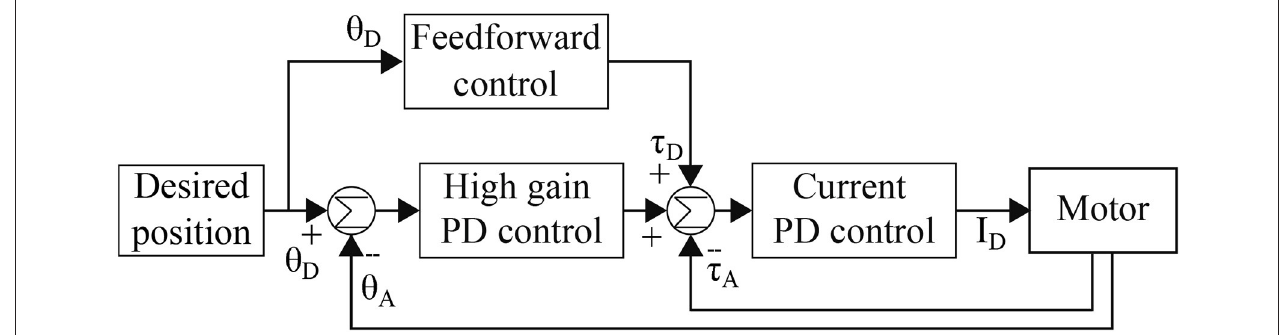
FIGURE 8 | Block diagram of compliant control mechanism loop: θ D and θ A represent the desired and actual joint positions, respectively; τ D and τ A are the desired and actual motor torques; and I D is the desired current for driving the motor.